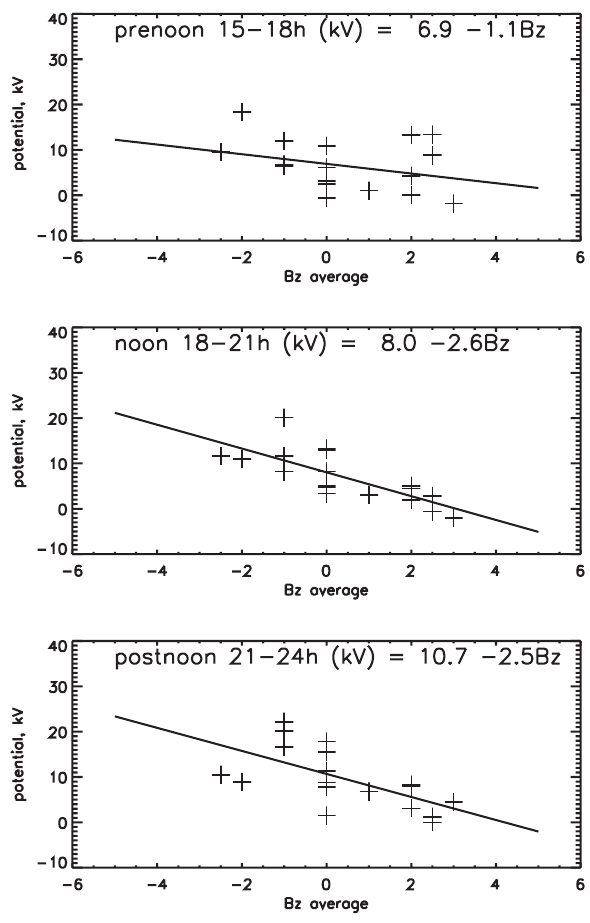
Fig. 4. Potentials calculated for three time intervals as a function of Figure 4. Potentials calculated for three time intervals as a function of IMF B z . The IMF B z . The equations of the fitted lines are shown equations of the fitted lines are shown.